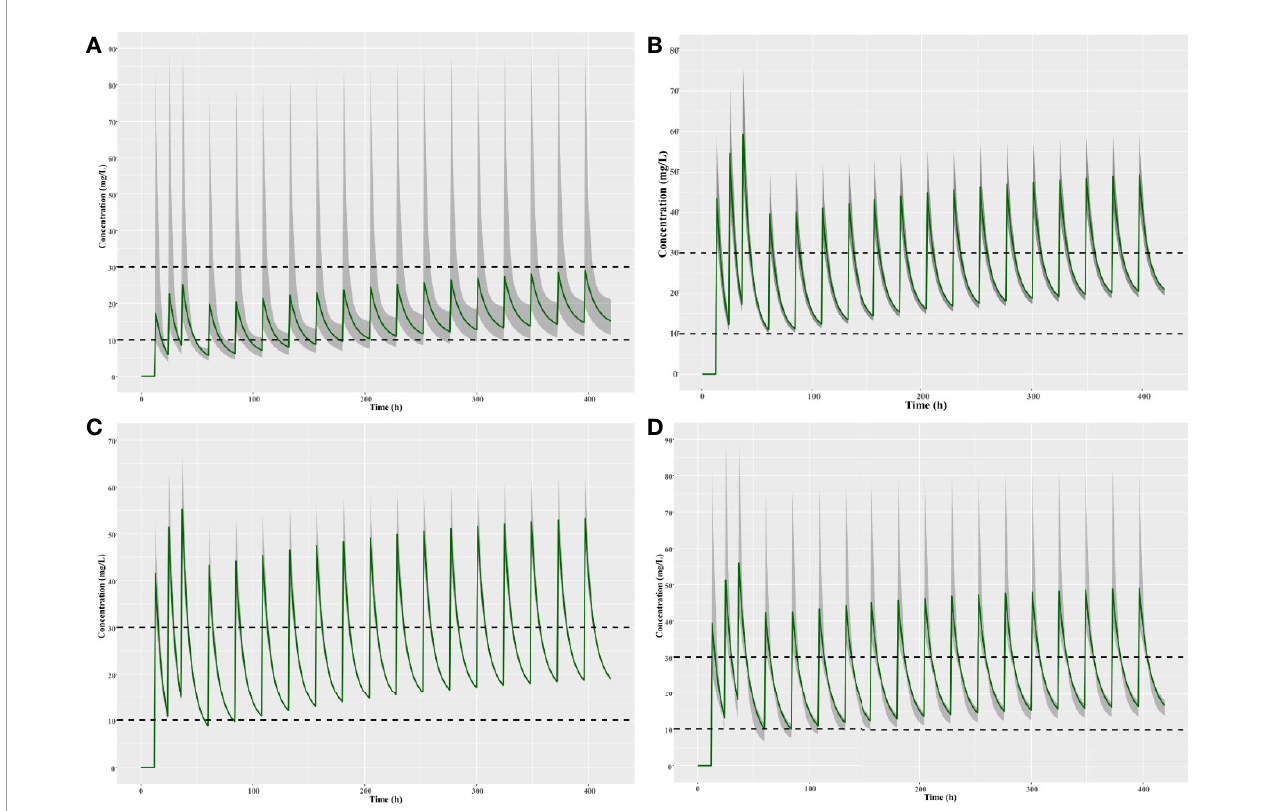
FIGURE 7 | Simulation of different teicoplanin dosage regimens for children with (A) moderate renal insuf fi ciency, (B) mild renal insuf fi ciency, (C) normal renal function, and (D) augmented renal function. The shaded area represents the 95% CI of the fi nal